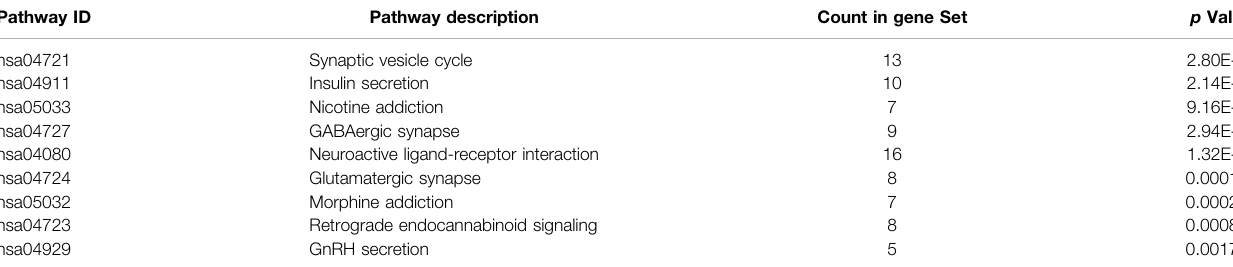
TABLE 1 | KEGG analysis for m6A Signature gene-A. Pathway ID